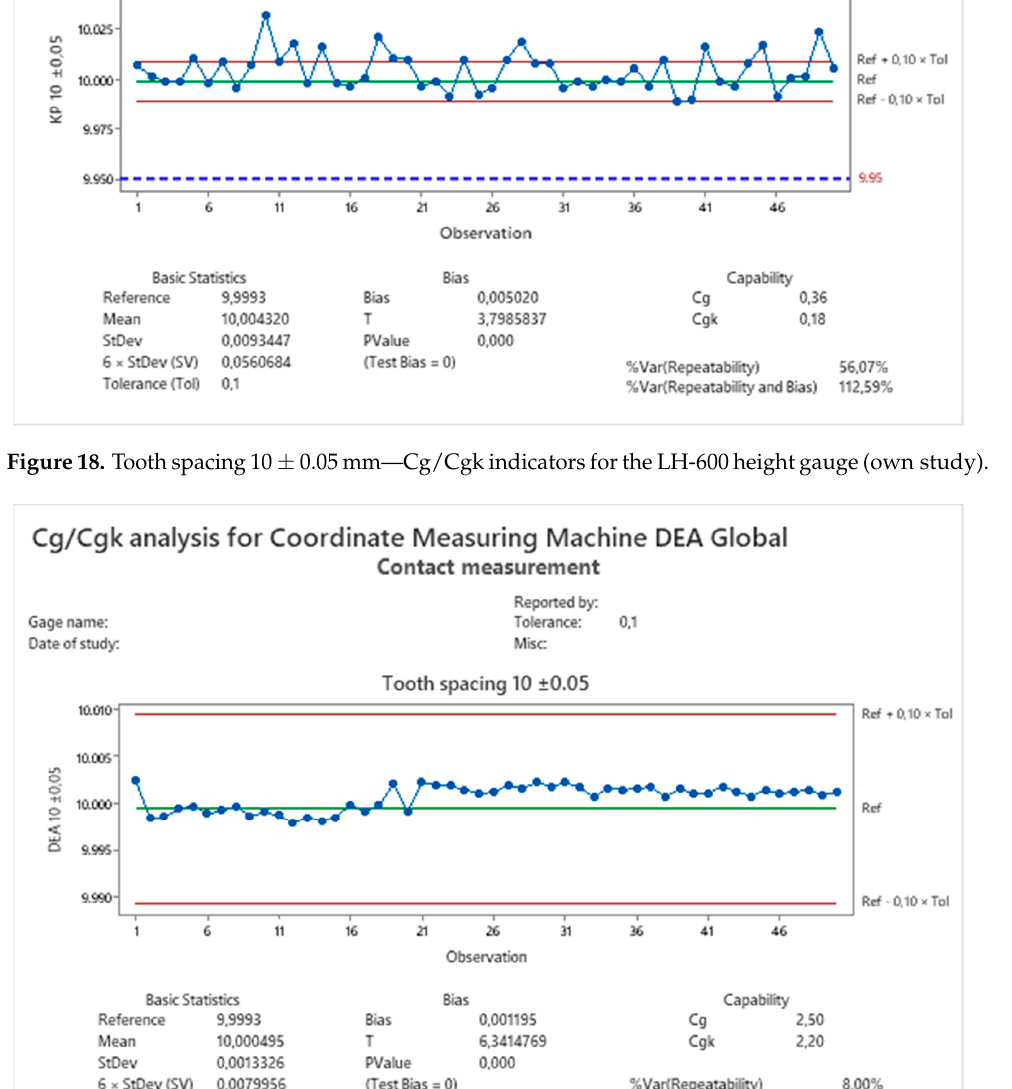
Figure 19. Tooth spacing 10 ± 0.05 mm—Cg/Cgk ratios for the DEA Global Coordinate Measuring Machine (own study).